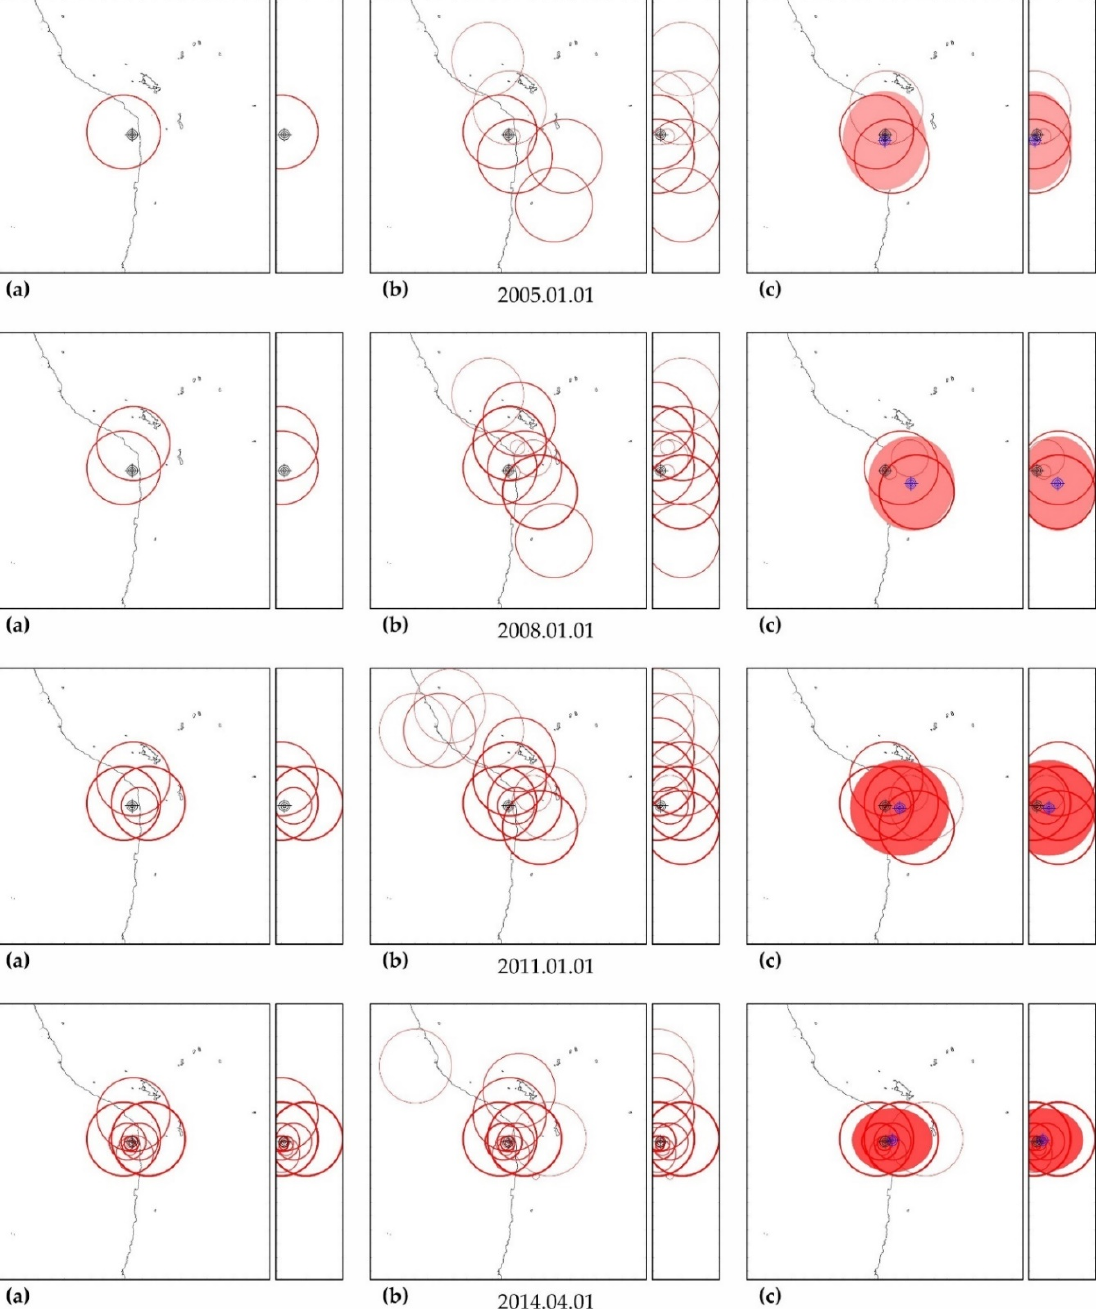
Figure A13. Zones of factual predictability for the earthquake of 1 April 2014 ( a ), identified zones with similar development according to the parameters of the DSDNP equation ( b ) and a cluster of zones of the greatest activity ( c ) used to calculate the time and place of a precedent earthquake (see Figure A3 for